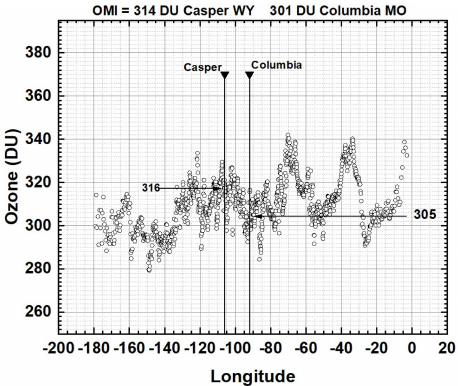
Figure A3. EPIC-measured ozone amounts from 20 August in the vicinity of Casper, WY, and Columbia,